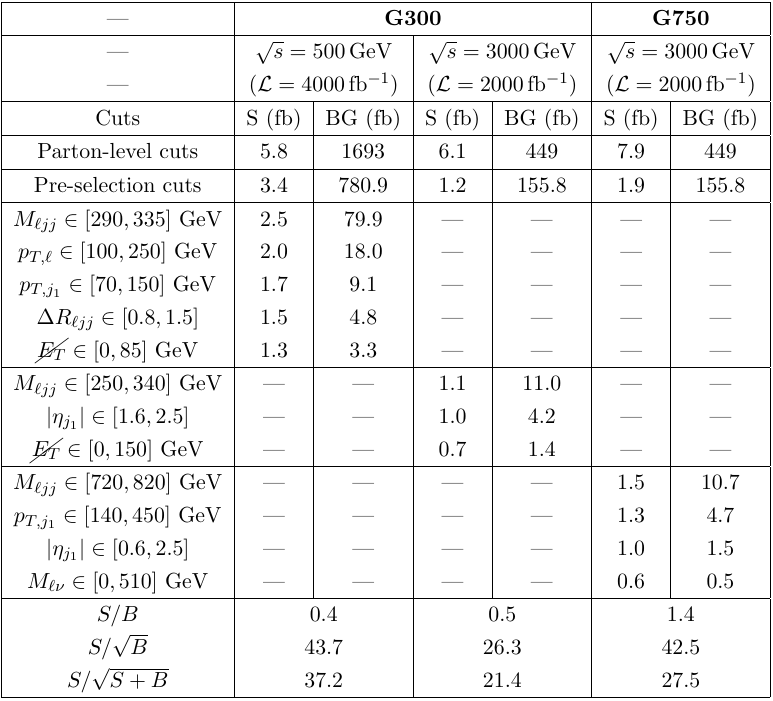
Table 8 . Cut (cid:13)ow table for generalized CW models: G300 and G750 . y The fact that we get 0 events is an artifact of low statistics of our background sample. When we estimate the signal signi(cid:12)cance, we used Poisson statistics and used 3 Madgraph events, which corresponds to 5.4 actual events with the integrated luminosity shown.